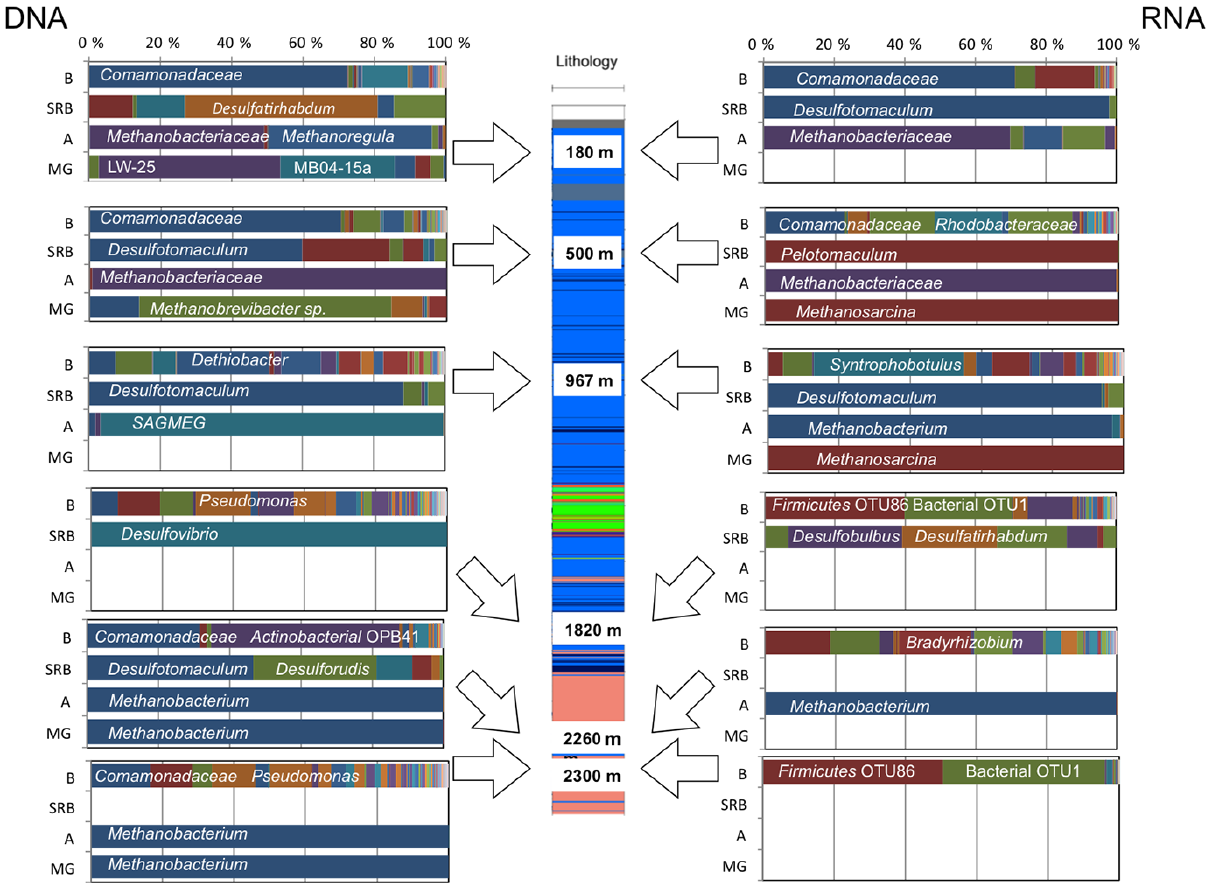
Figure 2. Microbial community structure at six different fractures in Outokumpu Precambrian crystalline bedrock. In the centre is a schematic presentation of the Outokumpu Deep Drill hole lithology (blue mica schist, green ophiolitic rocks, pink pegmatitic granite) with arrows pointing to the depths of the fractures studied. The composition of the total communities on the left and the active communities on the right side. The taxonomic classification of only the most abundant OTUs is shown. B: bacteria; SRB: sulfate-reducing bacteria; A: archaea; MG: